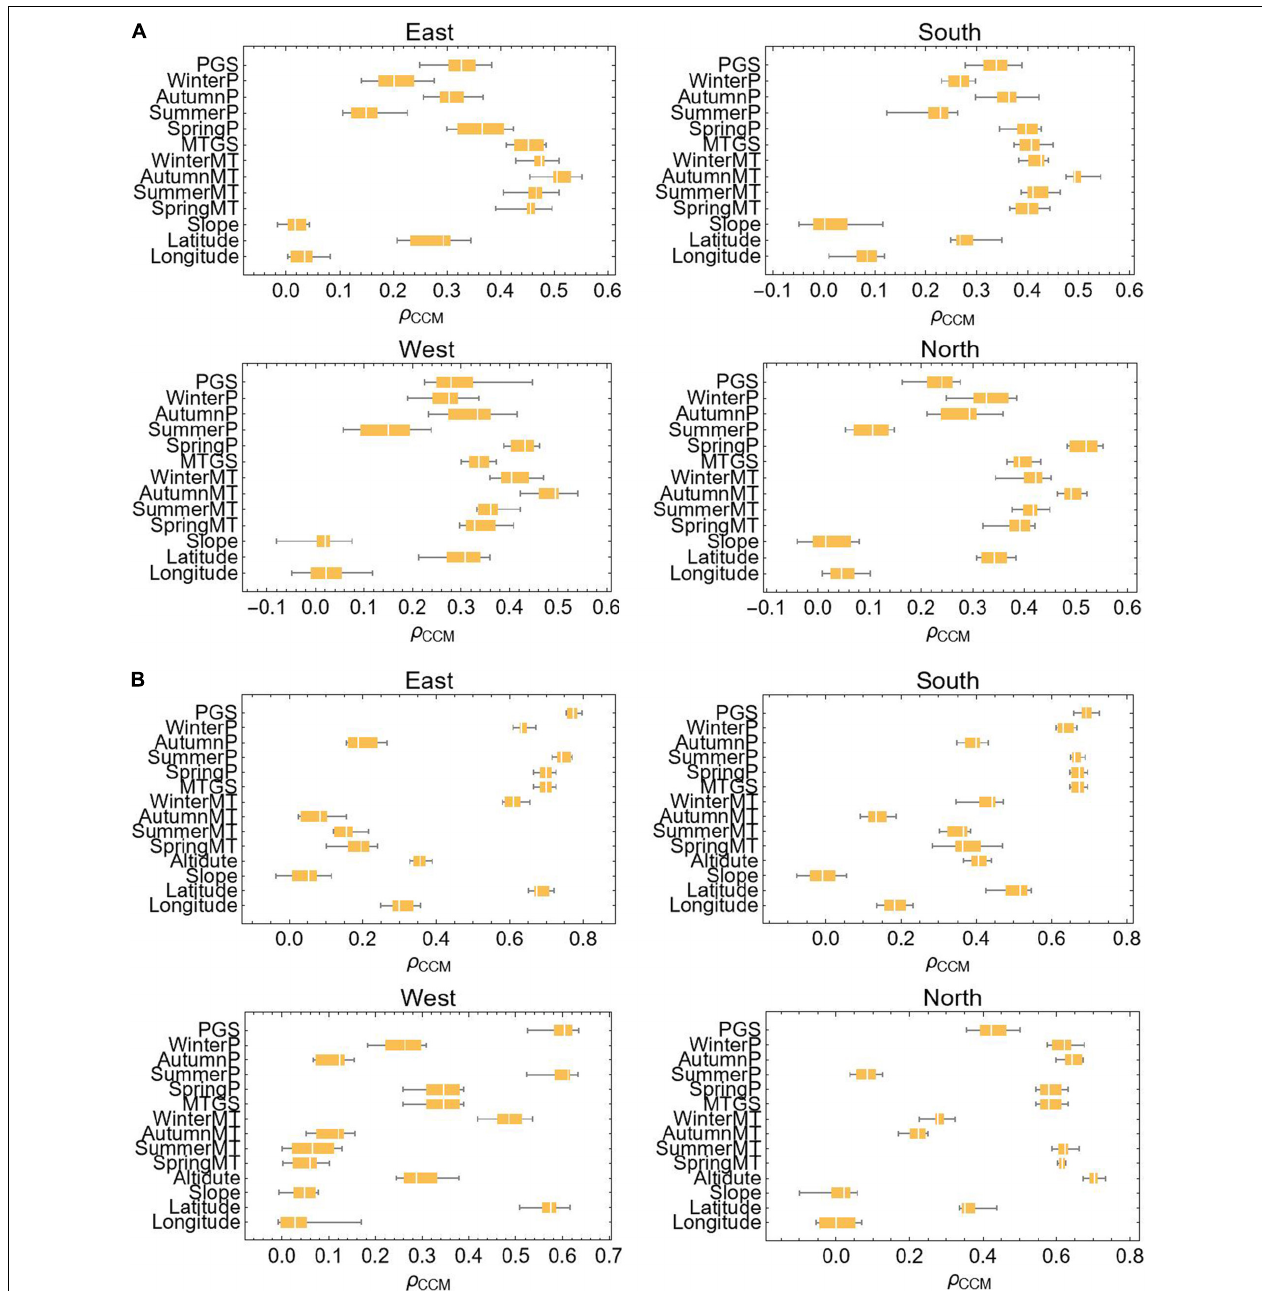
FIGURE 4 | Causality test of factors affecting treeline elevation. (A) Treeline elevation; (B) the fraction vegetation cover; ρ CCM represents the strength of causality.